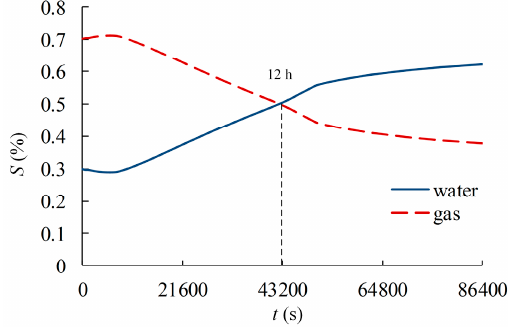
Figure 6. The change curves of saturation, S , with time, t.